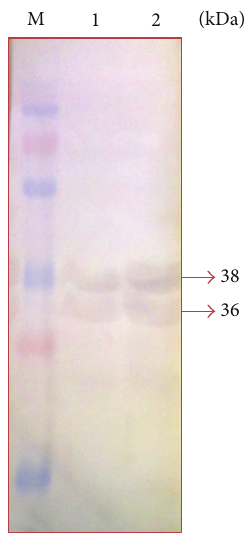
Figure 5: Immunodominant outer membrane proteins of Pas- teurella multocida B:2 in vaccinated sera. Lane M: protein marker (170–15 kDa). Lane 1: immunodominant protein in normal condi- tion. Lane 2: immunodominant proteins in iron-limited